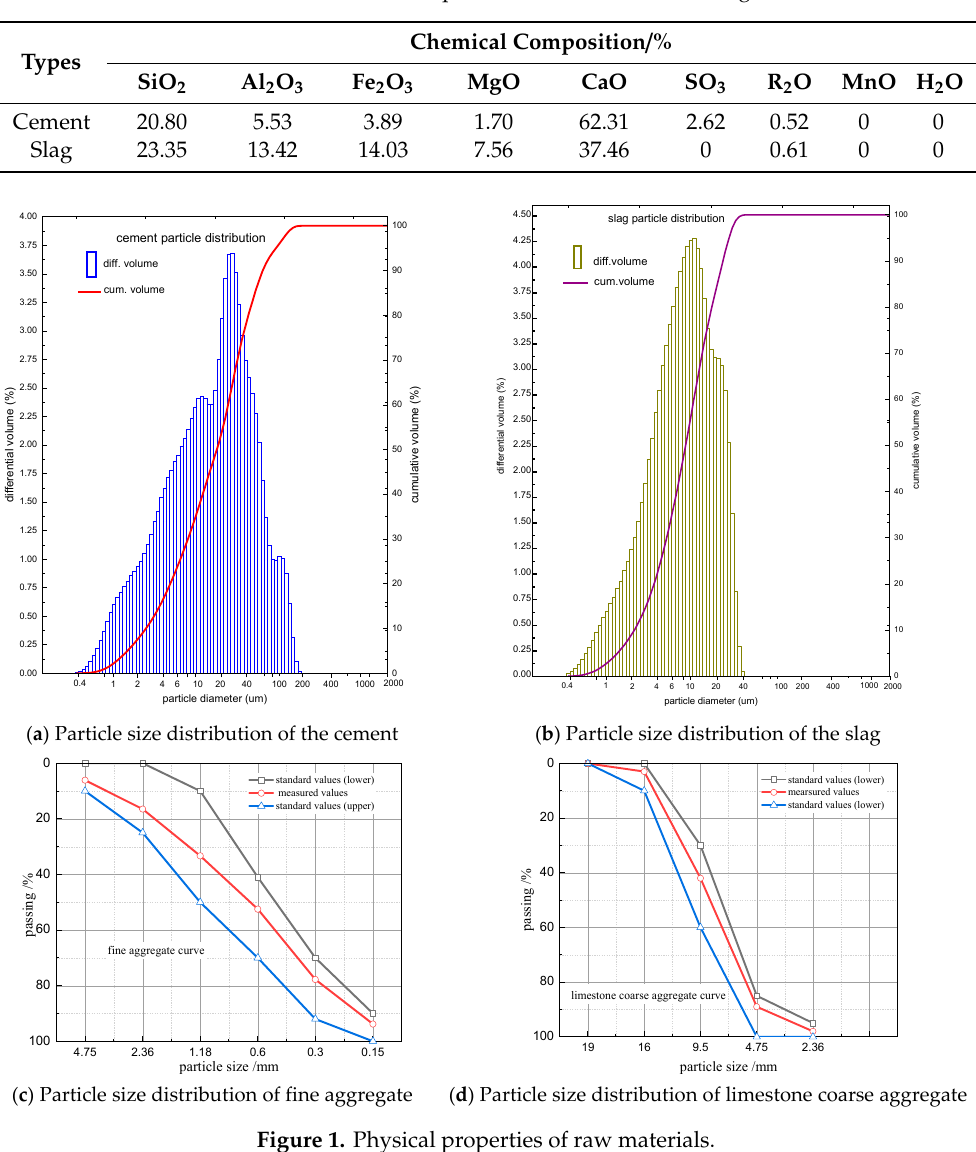
Figure 1. Physical properties of raw materials.